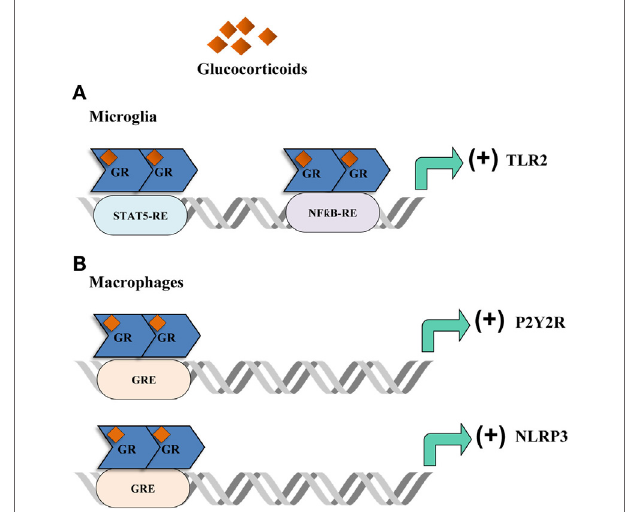
FiGURe 3 | Glucocorticoids (GCs) actions in the brain. Acute stressors promote an inflammatory phenotype in the brain. (A) In the microglia, GCs bind to the glucocorticoid receptor (GR) which then promotes the translation of the toll-like receptor 2 (TLR2) by interacting with STAT5 and NF ƙ B response elements. TLR2 then exerts a pro-inflammatory response by promoting the production of inflammatory cytokines. (B) In macrophages, GCs promote the expression of the purinergic receptor P2Y2R which then produces IL-6 in response to ATP. Moreover, GCs enhance the expression of NLRP3 which in turn promotes the production of pro-inflammatory